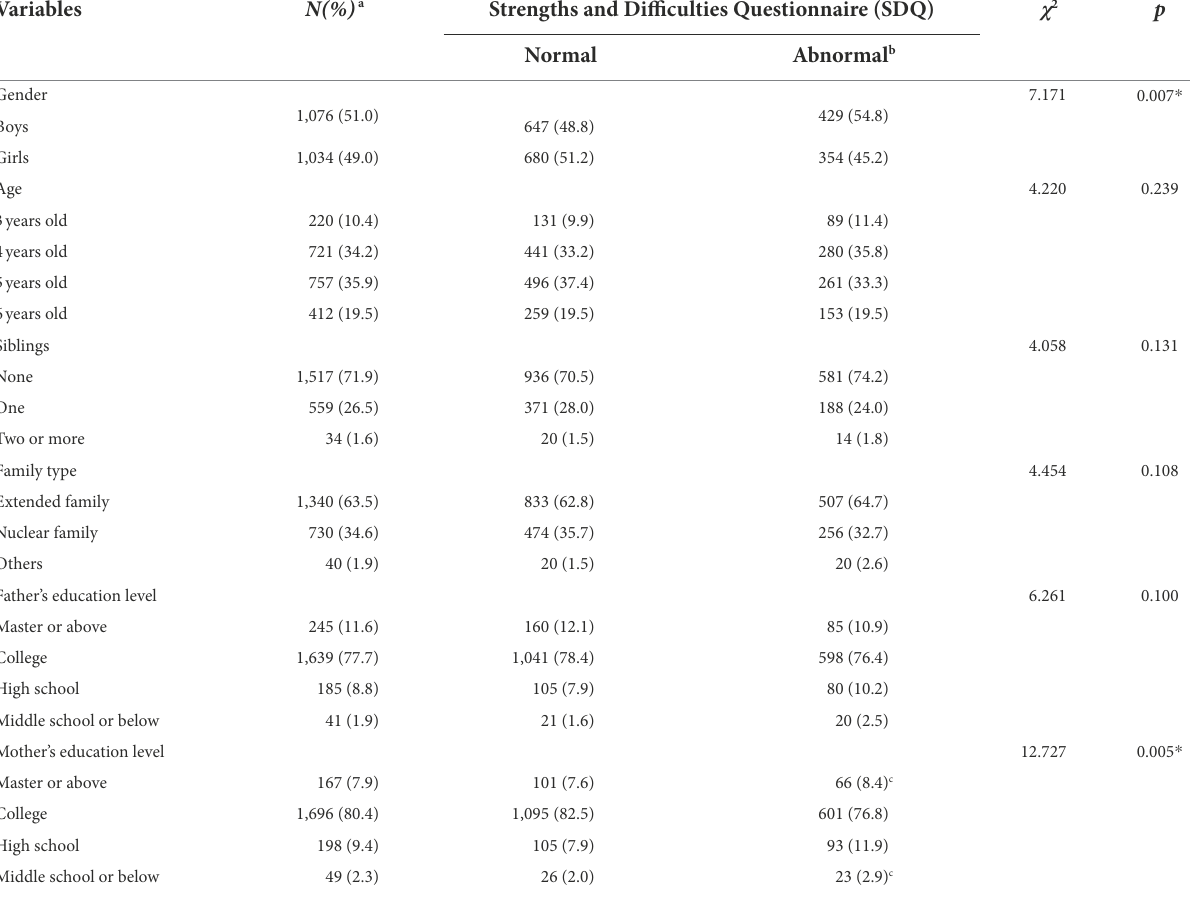
TABLE 1 Prevalence of preschool children’s mental health problems by sociodemographic